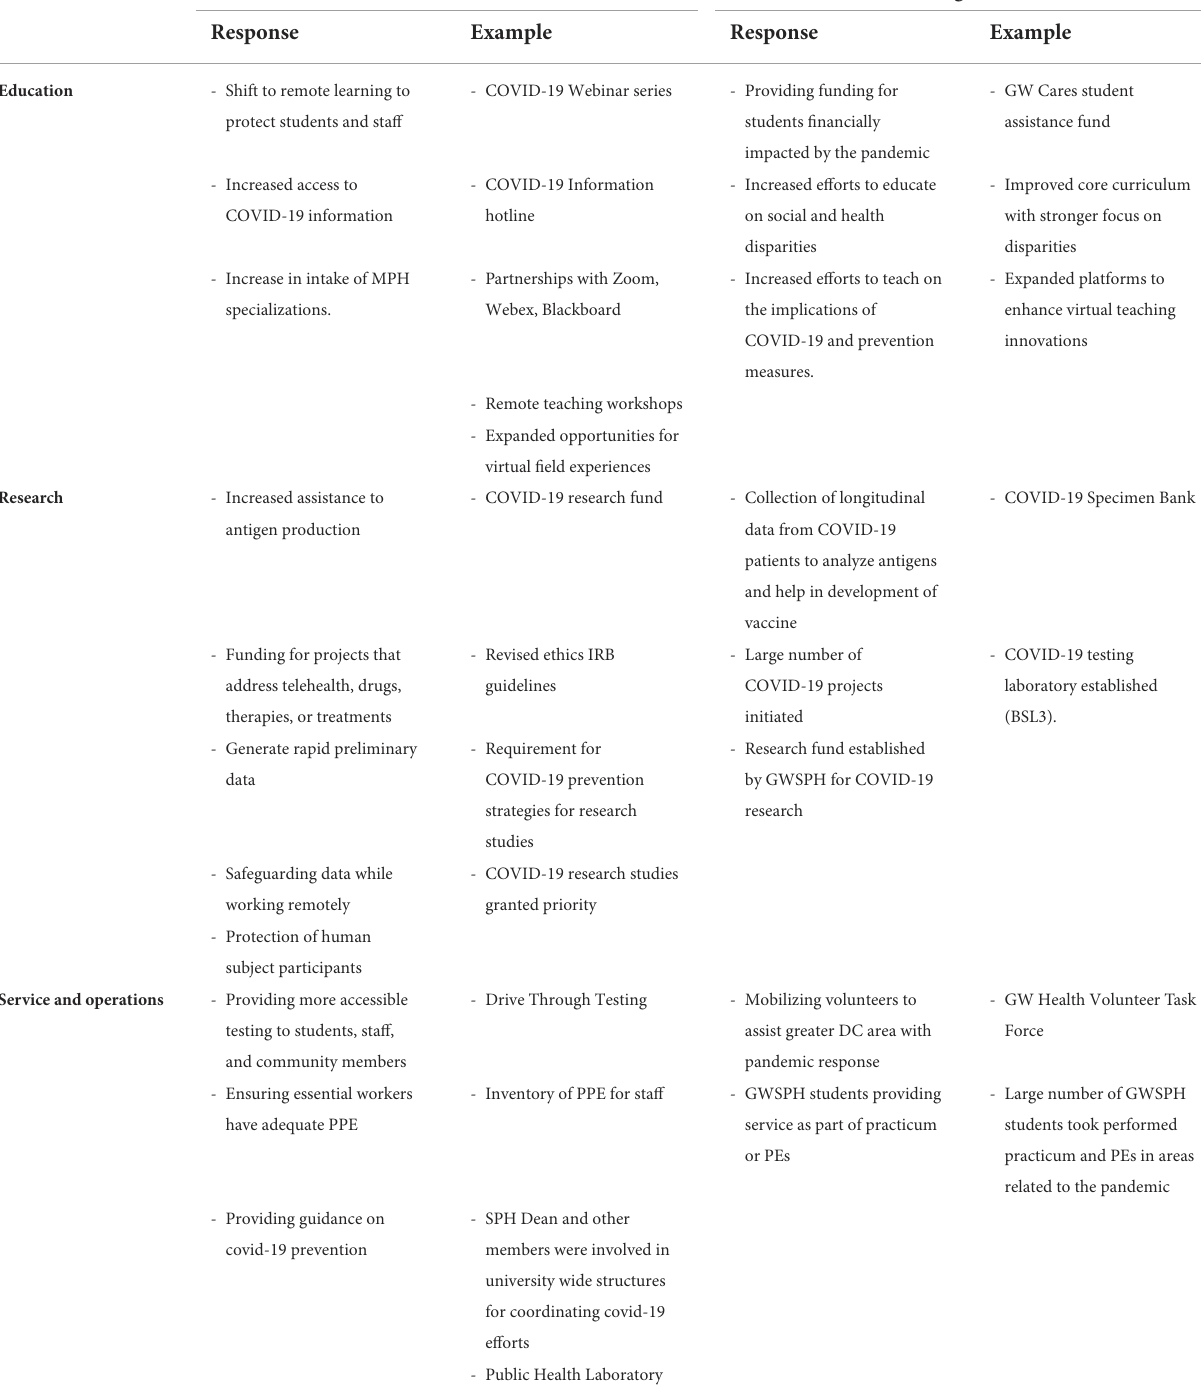
TABLE 1 GWSPH responses to the COVID-19 pandemic (examples).